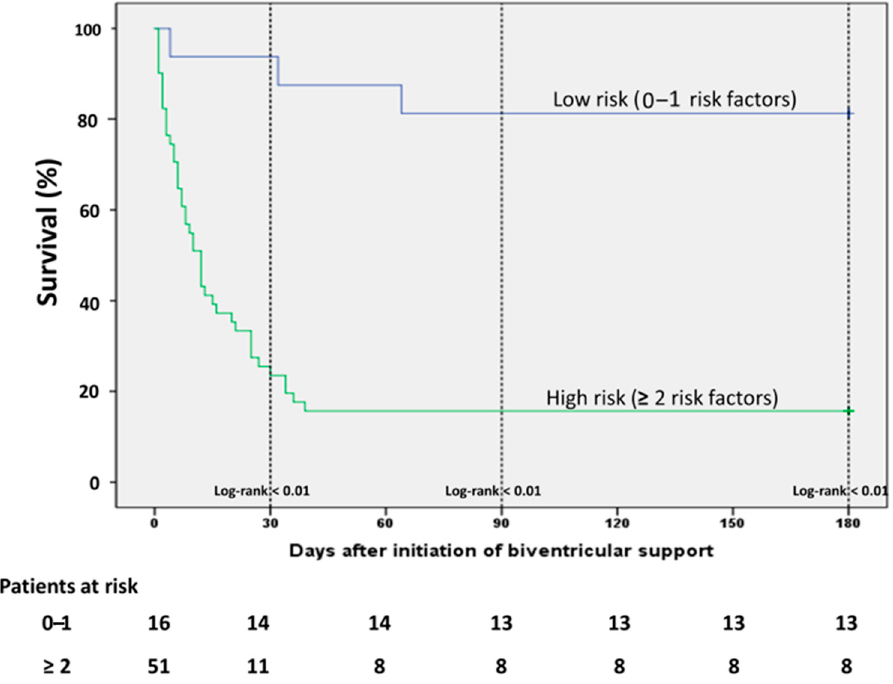
Figure 4. Kaplan Maier Analysis curve among patients in the various risk groups. The patients with none or only one risk factor demonstrate significantly better survival (risk factors: lactate > 6 mmol/L, pH < 7.26, vasoactive score > 100, CCI > 3, prior resuscitation). In none of the patients was a major displacement of the device observed. The most frequent observed access site bleeding requiring red blood cells transfusion. Complication requiring intervention or removal of device occurred in 13 patients (19.4%). All survival and complications rates are listed on Table 4. Table 4. Survival and safety outcomes.